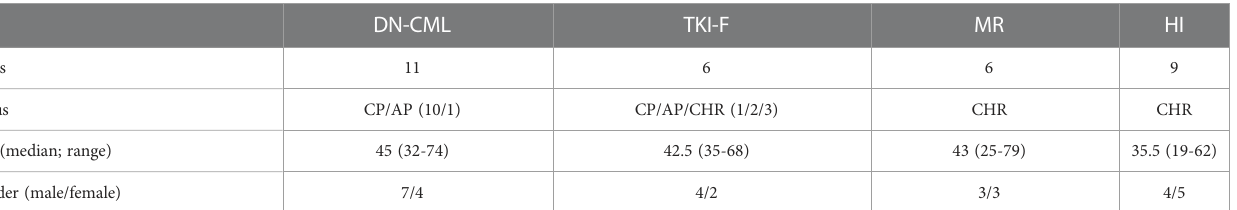
TABLE 2 Bone marrow sample characteristics.